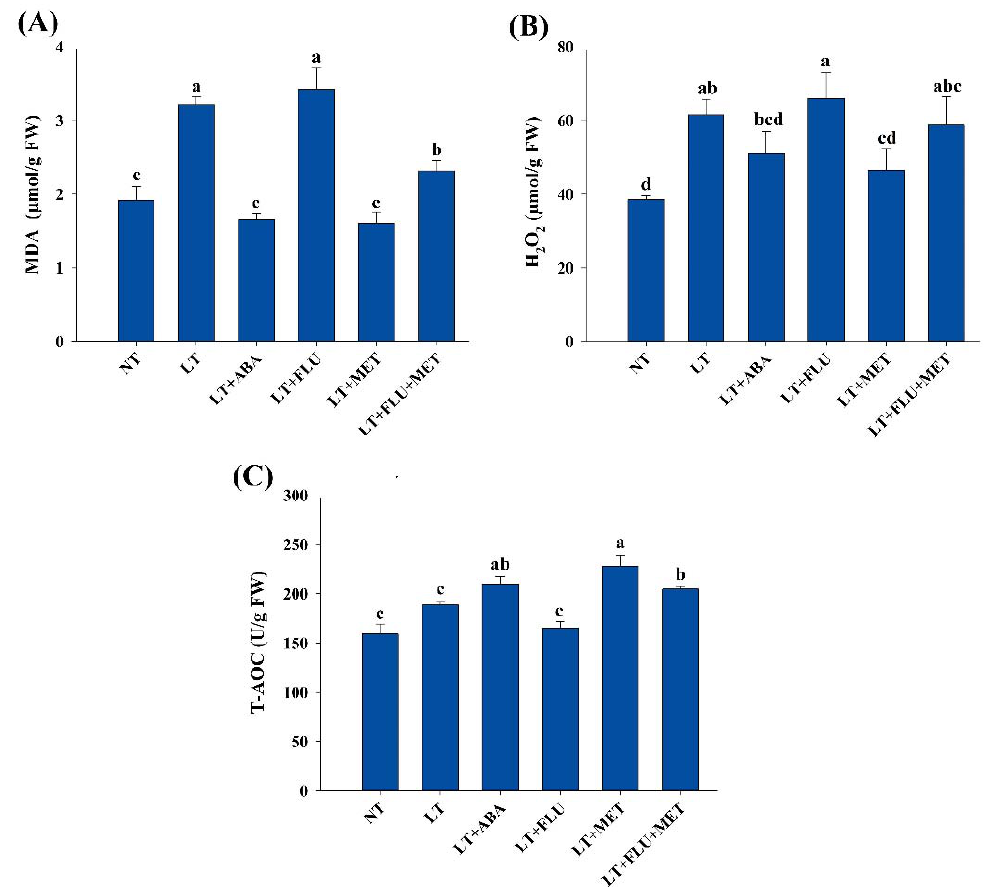
Figure 6. Effects of exogenous melatonin and ABA on melatonin on MDA ( A ), H 2 O 2 ( B ), and total antioxidant capacity (T-AOC) ( C ) in strawberry seedlings under cold stress. Plants treated with distilled water under the normal conditions (25 ◦ C) served as control (NT). The strawberry seedlings were pretreated with distilled water (LT), 100 µ M ABA (LT + ABA), 50 µ M fluridone (LT + FLU), 100 µ M melatonin (LT + MET), and 50 µ M fluridone + 100 µ M melatonin (LT + FLU + MET) 3 times in a two-day interval and then exposed to cold stress for 2 days. Graphs represent the mean of three biological replicates. Values labeled with different letters indicate significant differences among treatments at ( p ≤ 0.05) by